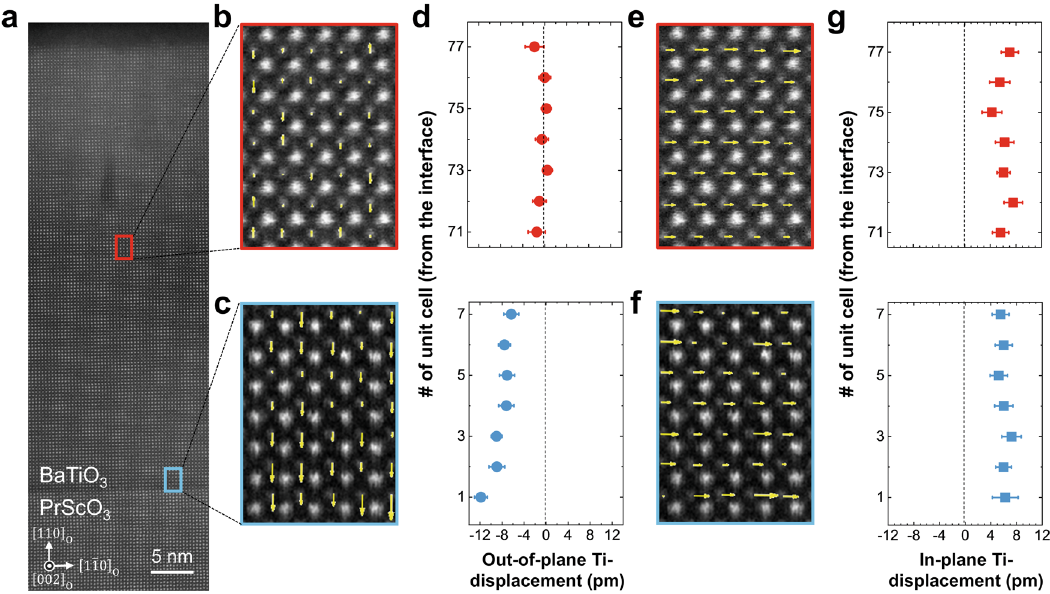
Fig. 3 STEM imaging and polarization measurements of BTO/PSO heterostructure. a A low-magni fi cation HAADF-STEM image of the BTO fi lm with a . b , c High resolution images taken from selected areas (red and blue boxes in Fig. 3( a ), respectively), shows out-of-plane zone axis of PSO ½ 002 (cid:2) O component of Ti-displacement in the middle region ( b ), and near the interface region ( c ) of the BTO fi lm, respectively. Note that the size of arrows corresponds to the amount of Ti-displacement. d Average value of out-of-plane Ti-displacement in each layer of BTO from the interface. e , f , High resolution images showing in-plane component of Ti-displacement in the middle region ( e ), and near the interface region ( f ) of the BTO fi lm. g Average in- plane Ti-displacement in each layer of BTO from the interface. Both out-of-plane and in-plane Ti-displacements are extracted from the same regions in the BTO fi lm. The error bars represent the 80% con fi dence intervals.